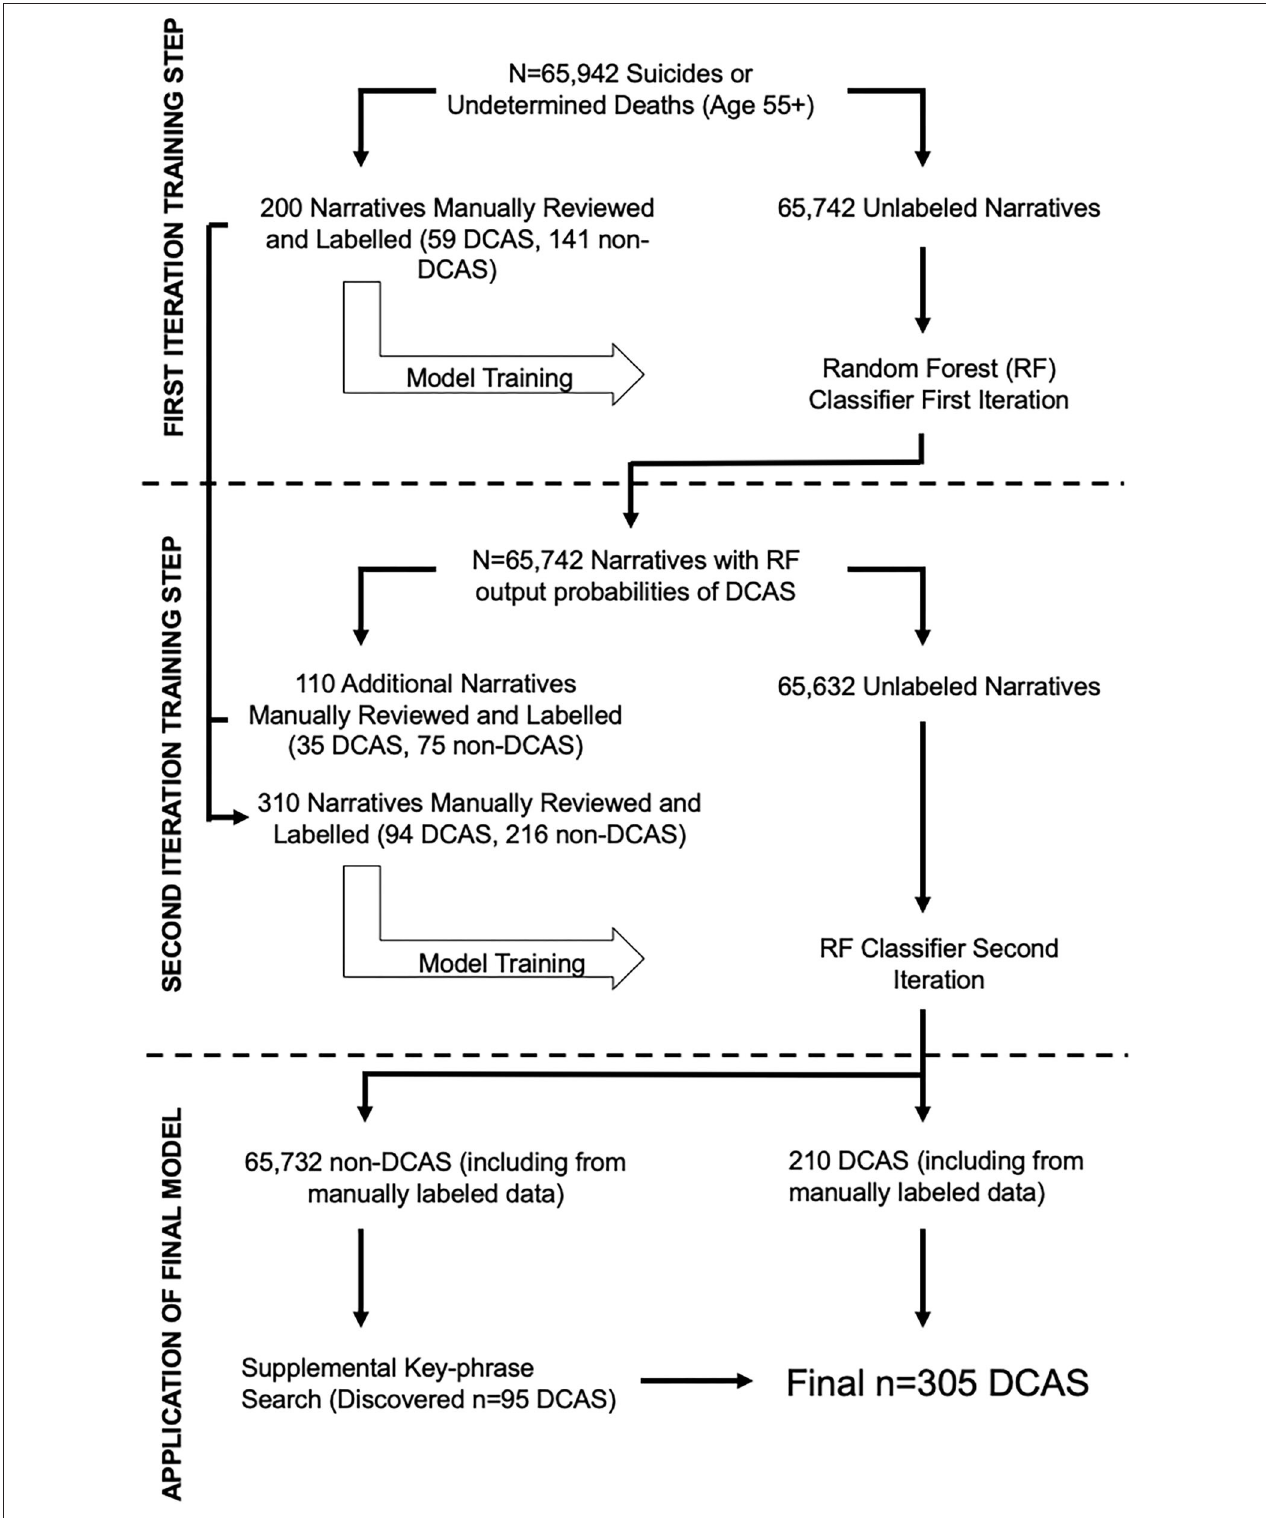
FIGURE 1 | The stepwise, iterative procedure used to develop the Natural Language Processing (NLP) classifier, which employs a supervised random forest algorithm, is illustrated. A supplemental key-phrase search was conducted to identify cases that may have been incorrectly missed by the classifier. DCAS denotes driving cessation associated